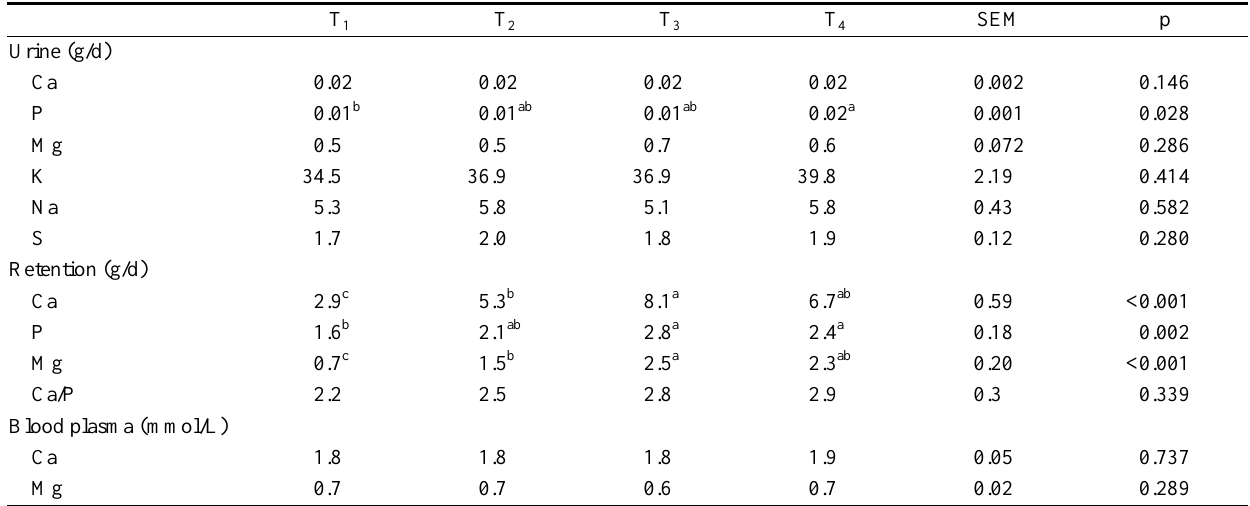
Table 4. Mineral excretion to urine, retention and concentration in blood plasma of cattle fed the four diets